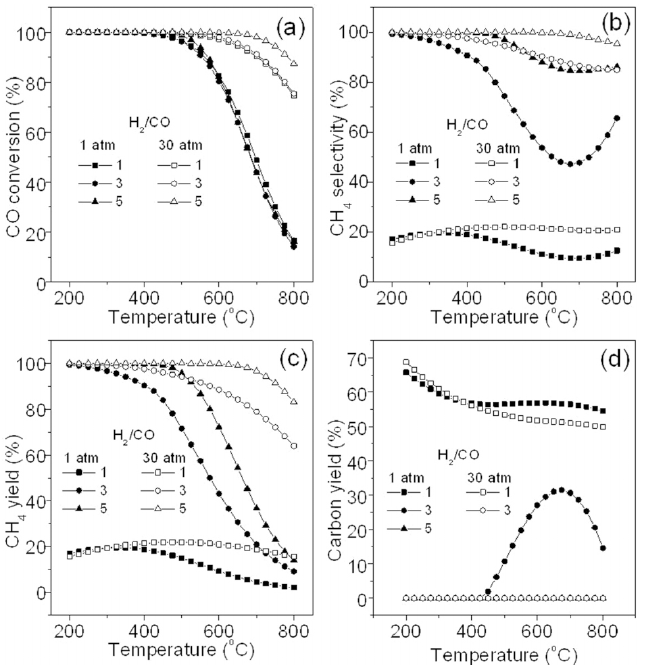
Figure 5. Effect of H 2 /CO ratio on CO conversion ( a ), CH 4 selectivity ( b ), CH 4 yield ( c ), and carbon yield ( d ). Reprinted from [18].